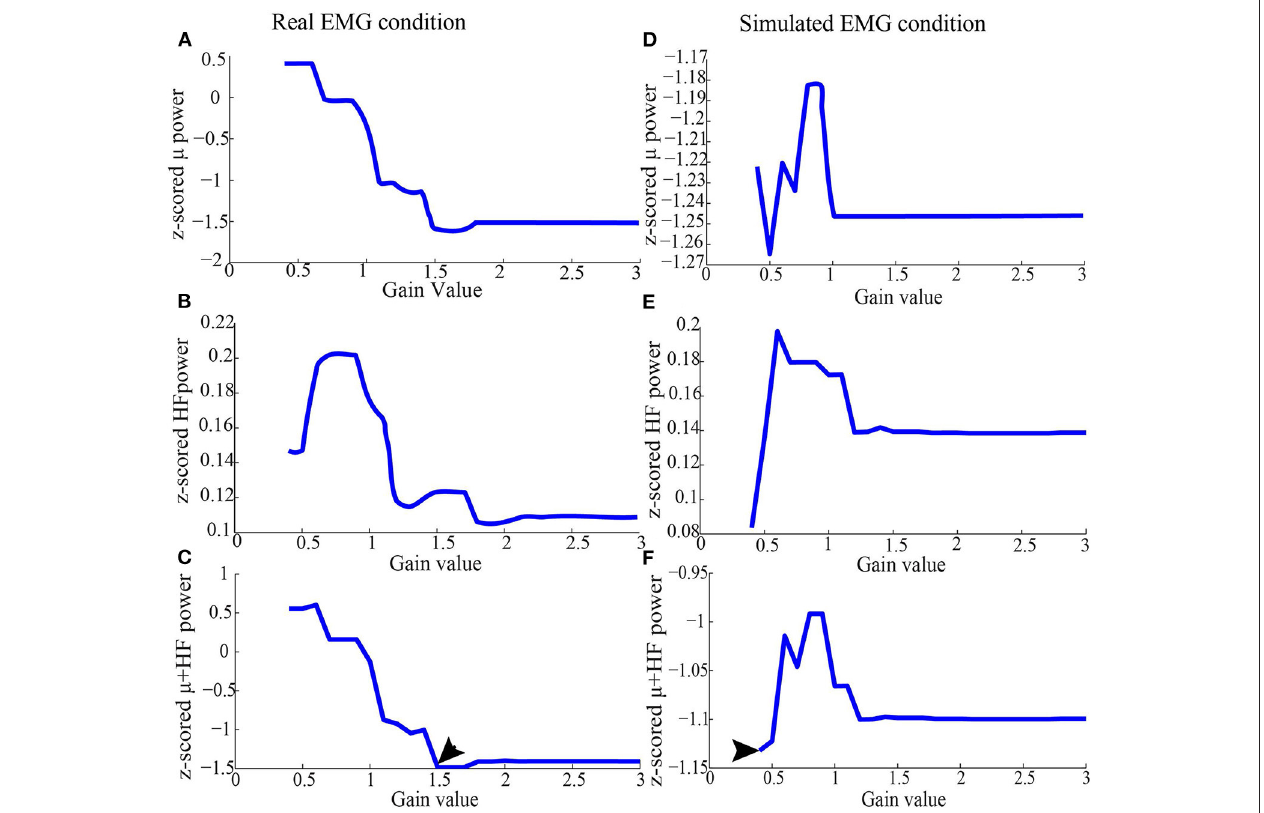
FIGURE 3 | Representative z-scored µ and high-frequency band power from Subject 1 after running ICA (as in section 2.3.2), using simulated EMG and real EMG. (A) Average of z-scored µ power in the C3 channel in the real EMG condition. (B) Average of z-scored high-frequency band power for all the EEG channels in the real EMG condition. (C) Values added by z-scored high-frequency band and µ power in the real EMG condition. (D) Average of z-scored µ power in the C3 channel in the simulated EMG condition. (E) Average of z-scored high-frequency band power for all the EEG channels in the simulated EMG condition. (F) Values added by z-scored high-frequency band and µ power in the simulated EMG condition. After running ICA on the combined EEG/EMG data, the artifact ICs were rejected based on the criteria depicted above for each threshold. After the joint consideration, the final threshold was 1.5 for real EMG condition, and 0.4 for simulated EMG, which were denoted by